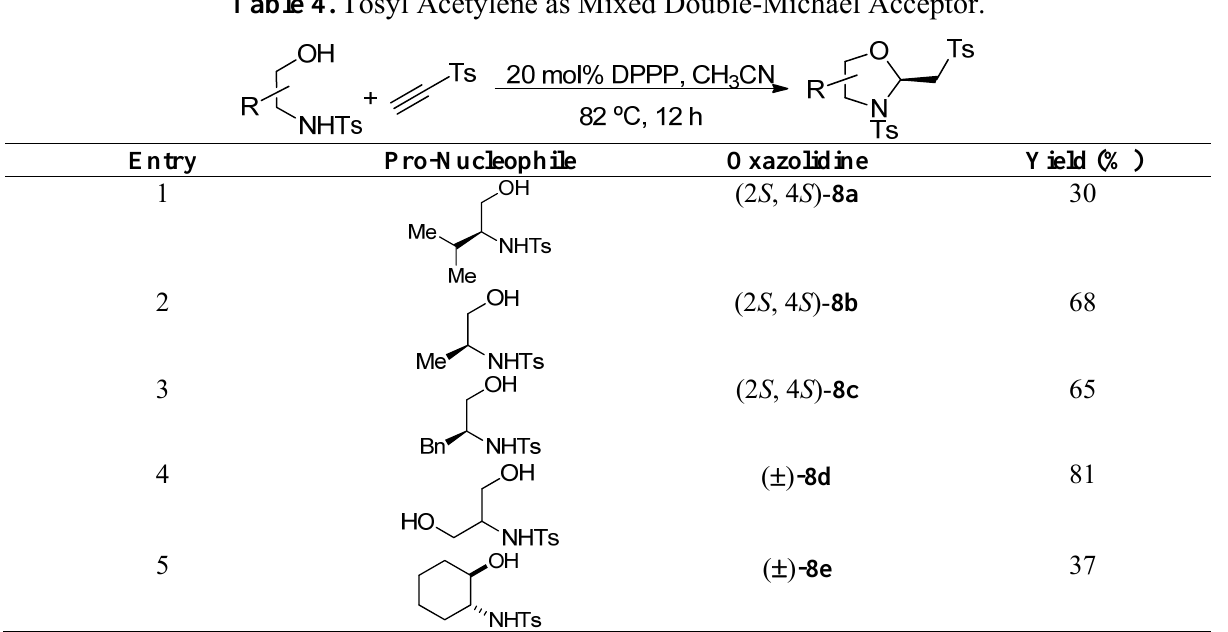
Table 4. Tosyl Acetylene as Mixed Double-Michael